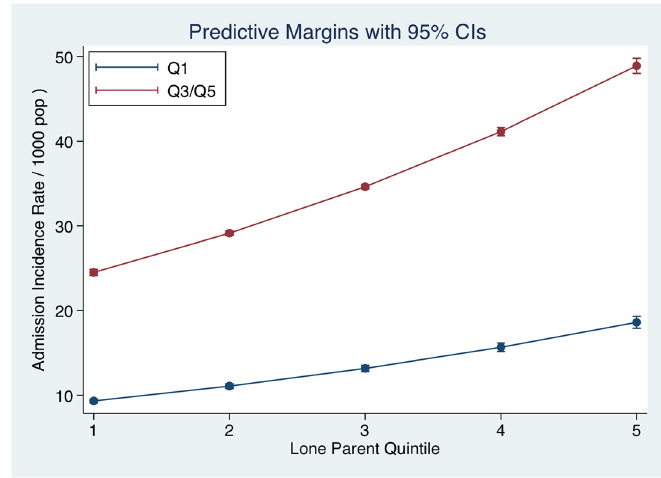
Figure 3. Relationship between Single ‐ Parent status and Admission Incidence Rate of an emergency medical admission. The predicted probabilities were derived from the multi ‐ variable truncated Poisson model. We used margins to estimate and interpret adjusted predictions for sub ‐ groups, while controlling for other variables, using computations of average marginal effects. Single ‐ Parent small area frequency predicted an increased admission rate, adjusted for Deprivation status.